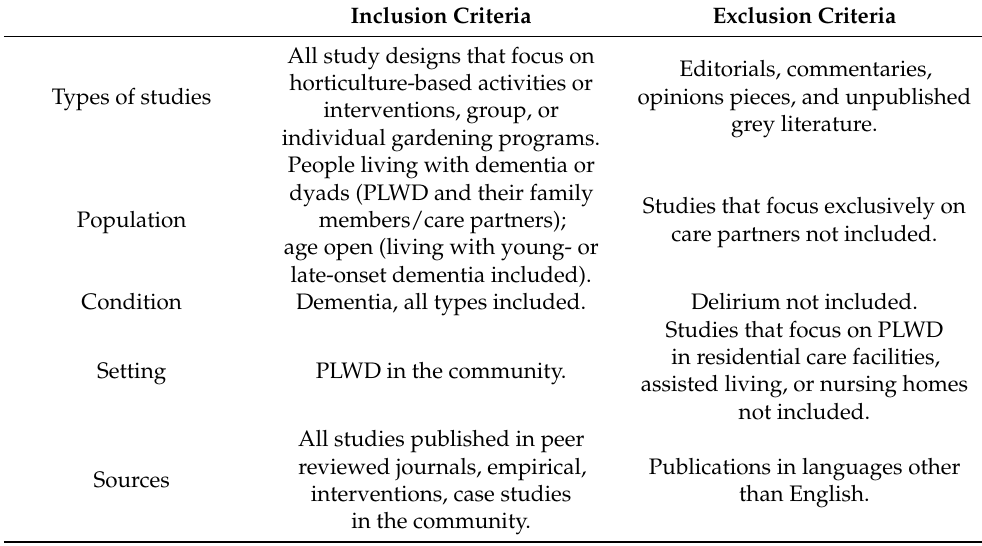
Table 1. Study eligibility